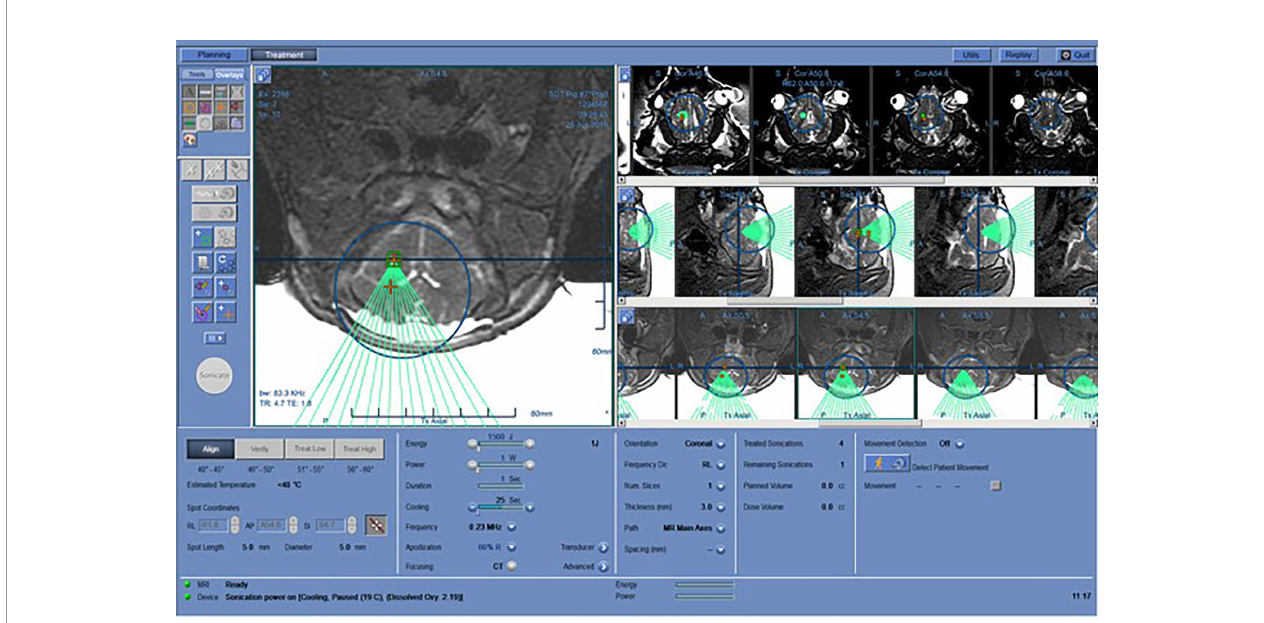
FIGURE 3 | Working layout of the Exablate system during insonation of one subject. The insonation pattern is superimposed on the pre-acquired MR images in different slices.